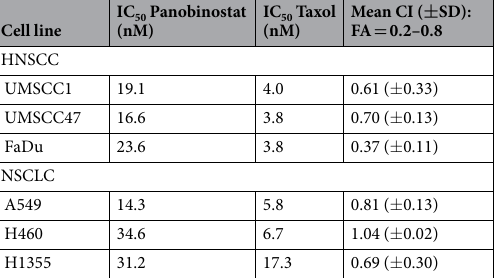
Table 1. Concurrent treatment of Taxol and Panobinostat is Synergistic in Human HNSCC and NSCLC cell lines. IC 50 doses were calculated for pano and Taxol. Drug interactions, computed by the software Calcusyn, were expressed as a Combination Index (CI). Drug interactions were defined as: synergy = CI ≤ 1.0, additivity = 1.0, and antagonism as CI ≥ 1. Data were expressed as mean Combination Index ( ± SD), determined for a range of drug concentrations over a Fractional Effect (FA) of